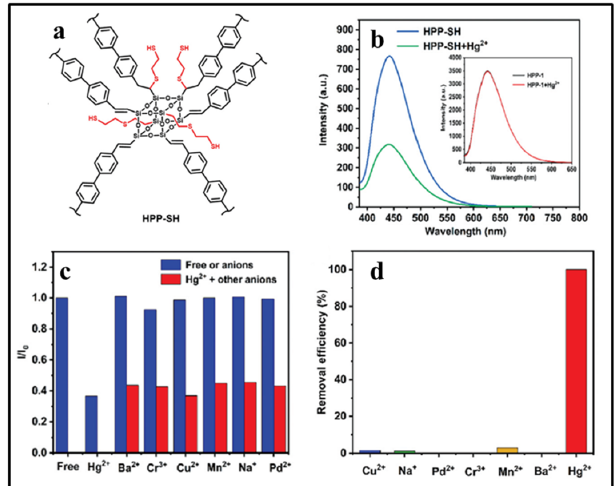
Figure 16. ( a ) Molecular structures of HPP-SH [94]; ( b ) the PL spectra of the HPP-SH suspension (0.1